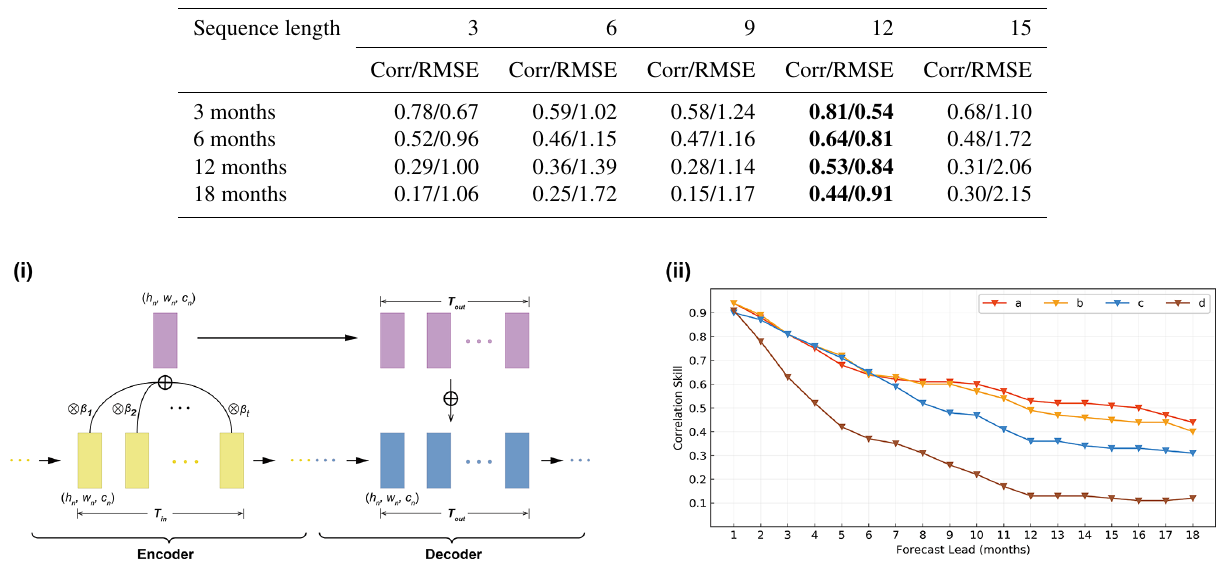
Figure 4. (i) The detailed structure of the skip-layer connection and attention mechanism between the encoder and decoder at the n th layer in ENSO-MC. (ii) The correlation skill of the Niño 3.4 index of the forecast lead month in models with different structures: (a) ENSO-MC model of skip-layer connection with attention mechanism and states connection, (b) ENSO-MC model without attention mechanism, (c) ENSO-MC model without states connection and (d) ENSO-MC model without skip-layer